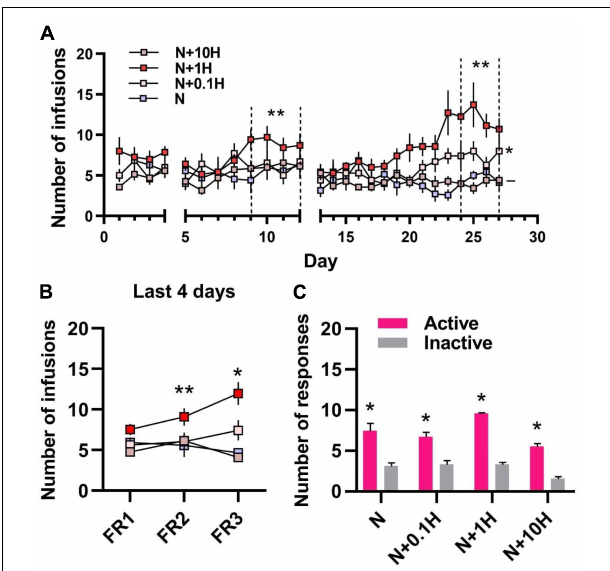
FIGURE 2 | Self-administration of nicotine with different doses of harmane in rats. (A) Number of infusions in FR1-FR3 self-administration. Blue square, 30 µ g/kg/inf nicotine group (N); pink square 30 µ g/kg/inf nicotine + harmane (0.1 µ g/kg/inf, N + 0.1H), red square, nicotine + harmane (1 µ g/kg/inf, N + 1H) and brown square, nicotine + harmane (10 µ g/kg/inf, N + 10H). The number of infusions in FR2-FR3 was significantly increased in the N + 1H group compared to the N group (** p < 0.01), while the N + 0.1H group was only significantly higher in FR3 (* p < 0.05), and the N + 10H group had no significant difference compared to the N group ( − p > 0.05). (B) Infusions in the FR1-FR3 last 4 days in each group. The number of infusions increased significantly from FR1 to FR3 in the N + 1 group (** p < 0.01 from FR1 to FR2 and * p < 0.05 from FR2 to FR3), while other groups did not increase. (C) Histograms of the response data in FR1. Active responses were significantly higher in all groups than inactive responses (* p < 0.05). Data are presented in the figure using mean ± SEM.